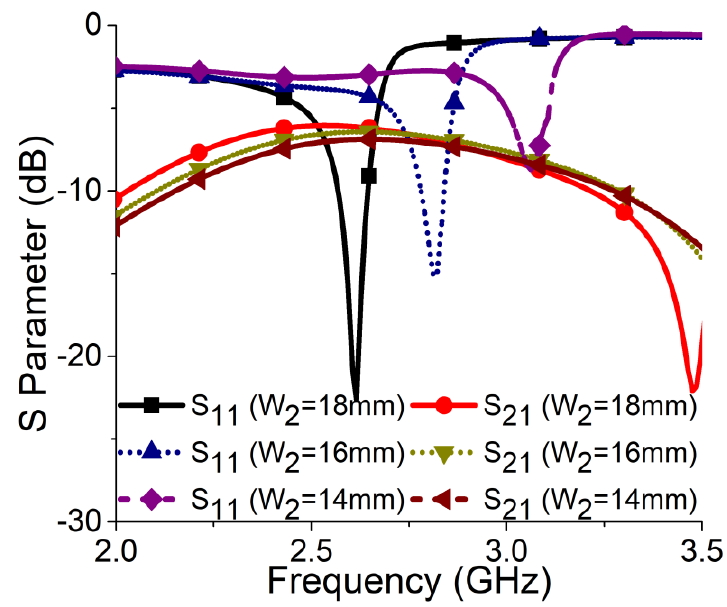
Figure 3. Effect of W 2 on resonance frequency.